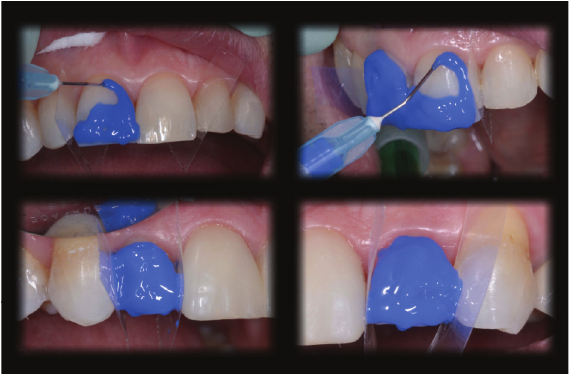
Figure 16: Phosphoric acid (38%) etching of enamel (30s).